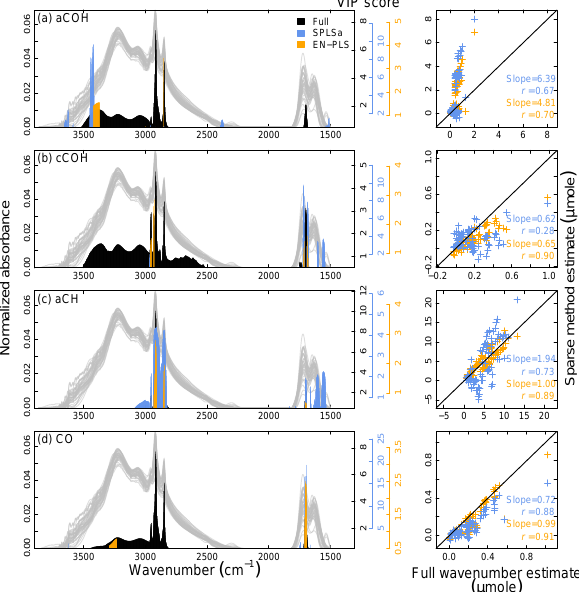
Figure 8. Example group of baseline corrected spectra shown with VIP scores above 0.5 overlayed. The VIP is derived from all cal- ibration spectra consisting of laboratory standards (same as those shown in Fig. 7). The column of panels on right show sensitivity of predictions for each FG for this subset of